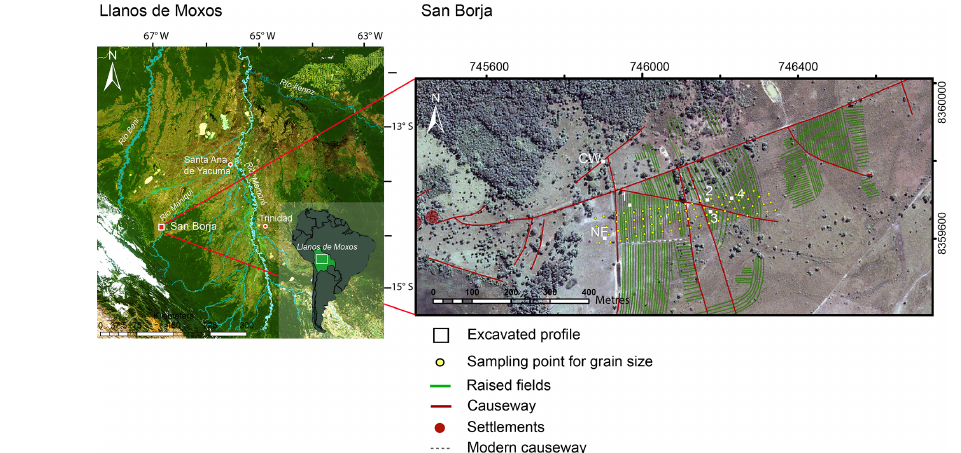
Figure 1. (a) MODIS image of the Llanos de Moxos in the Bolivian Lowlands including a small continent map of South America. (b) Zoom in to the study area in San Borja showing raised fields and causeways, including the location of the excavated profiles and locations sampled for grain size analysis. Image source: Google